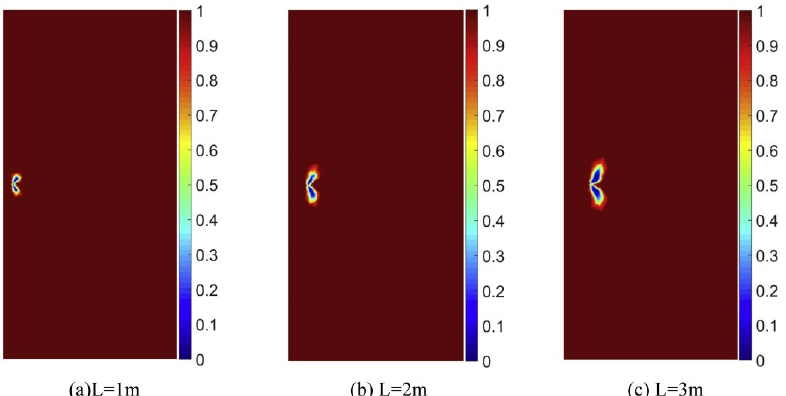
Figure 13. The plastic zone simulated by CZM with Drucker–Prager yield criterion. Reprinted with permission from Ref. [233]. Copyright 2018, Elsevier.